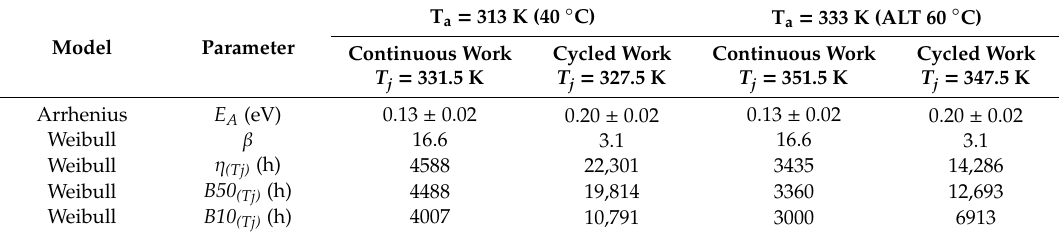
Table 3. Values of main lifetime parameters for ALT at 60 ◦ C and evaluation results by